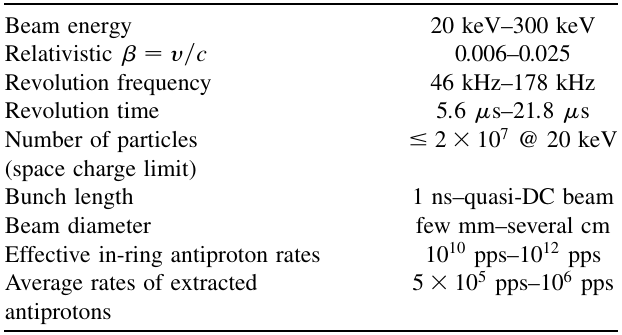
TABLE I. General parameters of antiproton beams at the